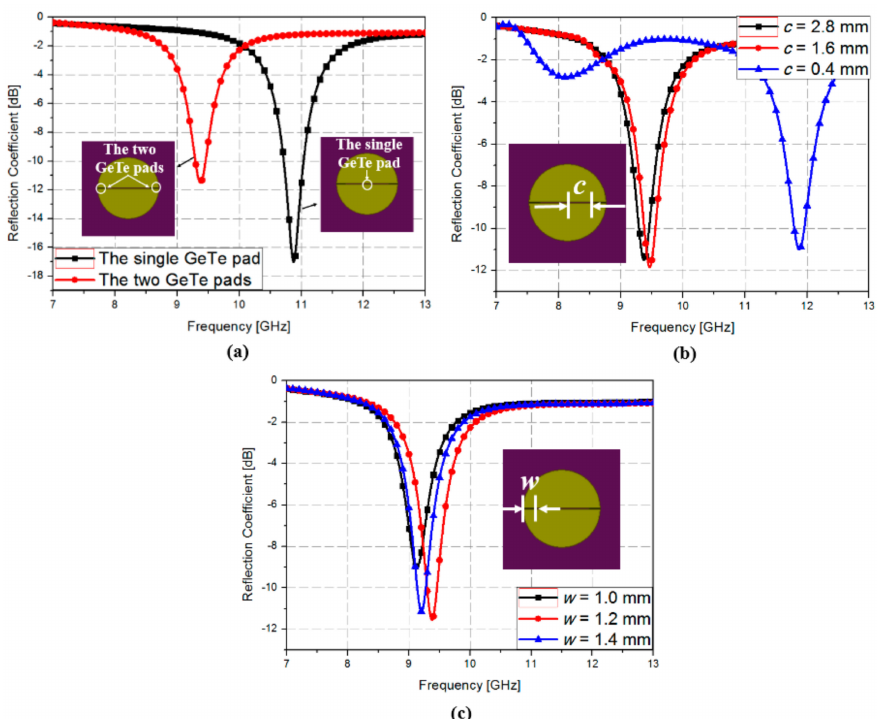
Figure 3. Simulated reflection coefficients of the absorber when GeTe is in the crystalline (ON) state ( a ) with a single GeTe pad and two GeTe pads ( b ) when c is varied from 0.4 to 2.8 mm with d = 8 mm ( c ) when w is varied from 1.0 mm to 1.4 mm with d = 8 mm and g = 0.1 mm.